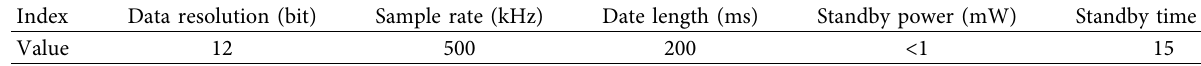
Table 1: Performance indexes of the DAR circuit.